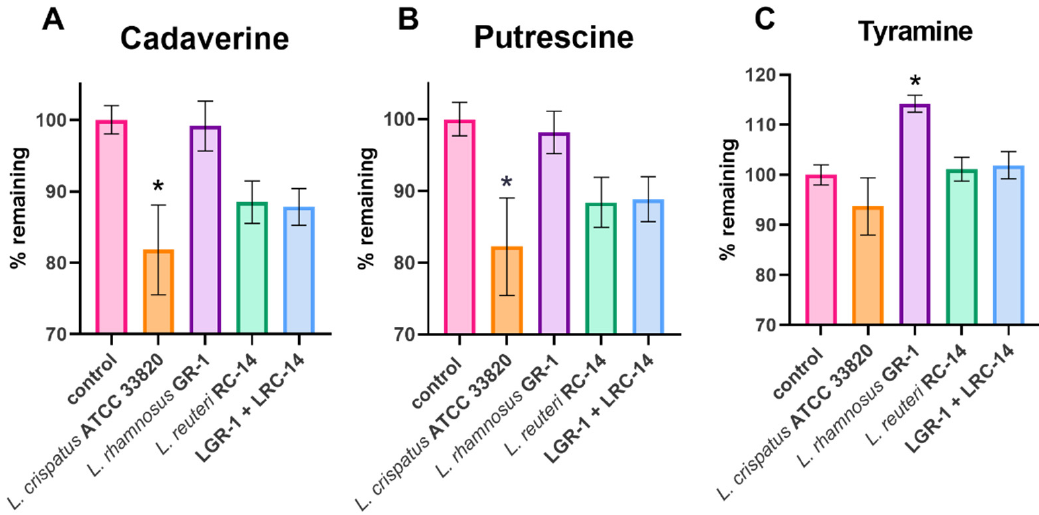
Figure 1. Metabolism of biogenic amines by different lactobacilli strains. Control consisted of media supplemented with each BA of interest. Bar plots show the remaining concentration of ( A ) cadaverine, ( B ) putrescine, and ( C ) tyramine, after 24 h of incubation with each strain of interest. Data are presented as means of 4 independent experiments ± 95% confidence intervals (CI). One-way ANOVA with the Dunnet correction for multiple comparisons was used to calculate statistical significance, * p ≤